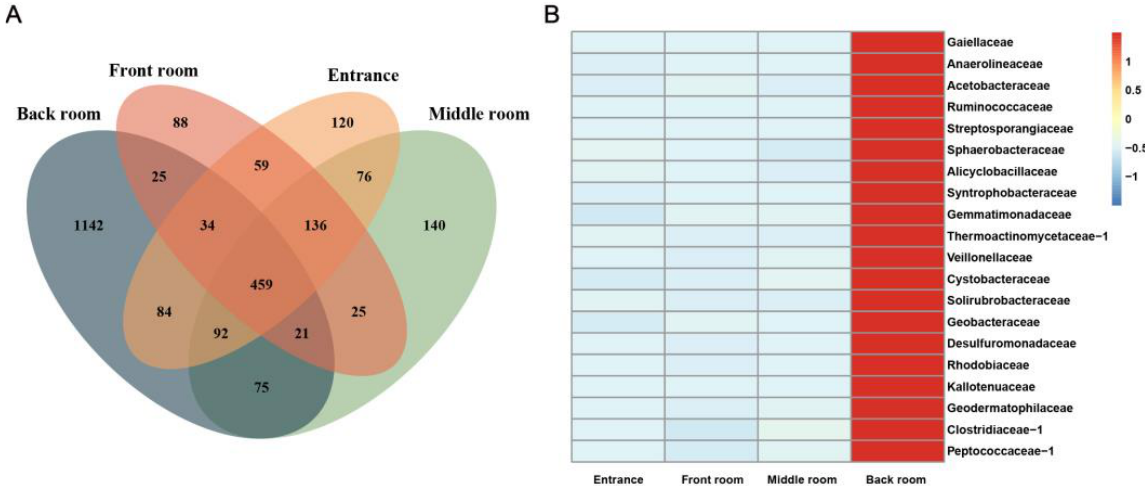
Figure 5. Endemic OTUs ’ taxa in the back room of Qinling Mausoleum. ( A ) Venn plot of OTUs ’ taxa among four positions in Qinling Mausoleum. ( B ) Heat map of family level species annotation of endemic OTUs for the top 20 abundances in Qinling Mausoleum back room.